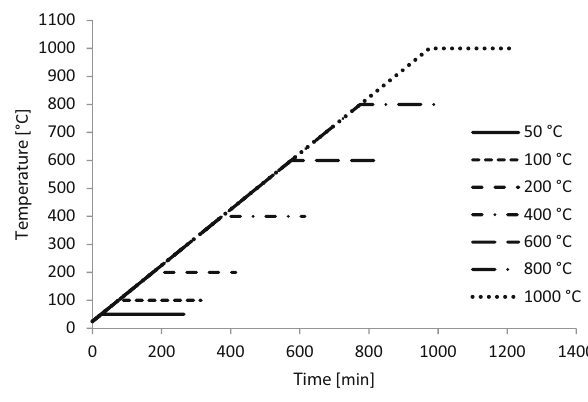
Figure 5: Heating scheme.